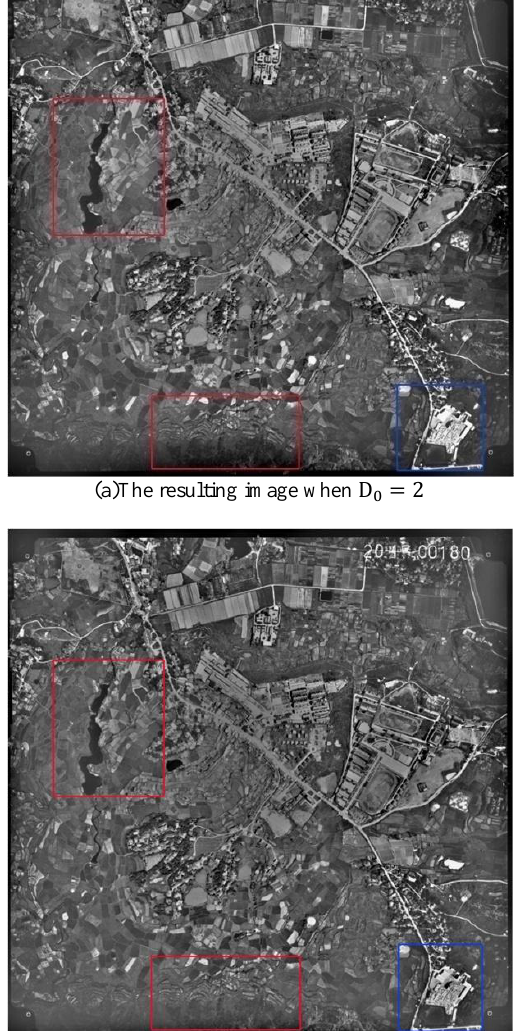
Figure 4. The resulting image when is the